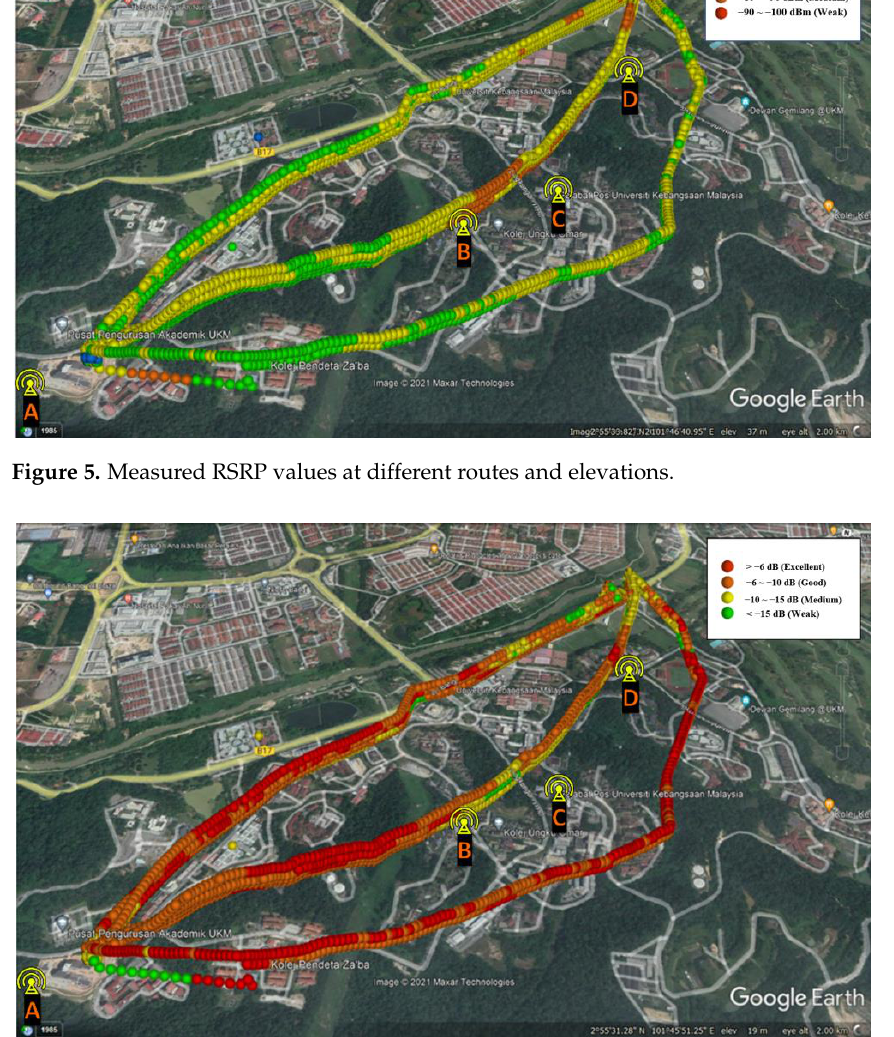
Figure 6. Measured RSRQ values at different routes and elevations.